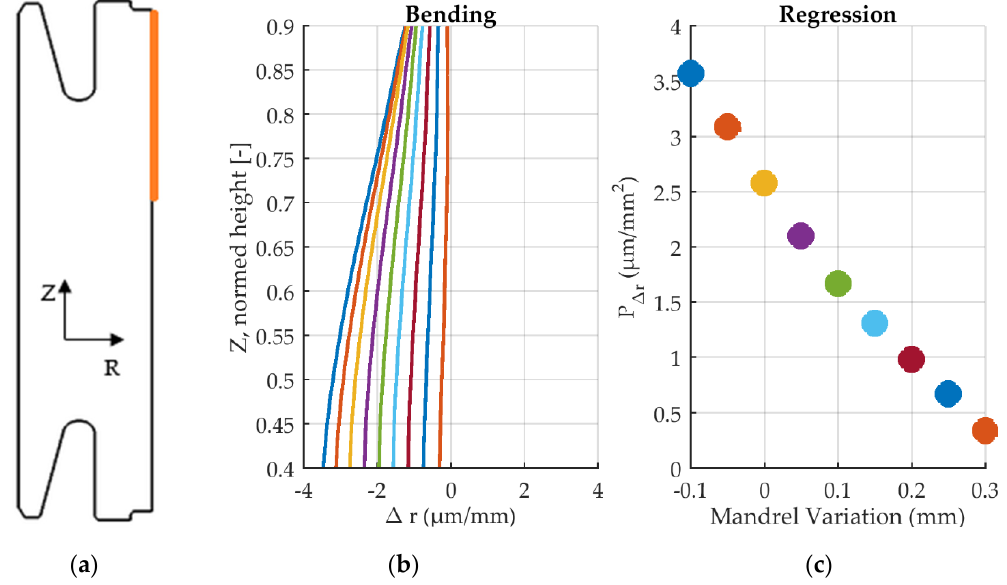
Figure 15. Bending of outer radius for all mandrel diameter variations in quenched state with contact